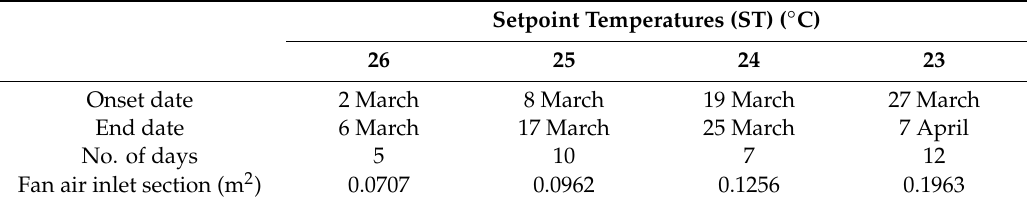
Table 1. Setpoint temperatures for environmental control and measurement